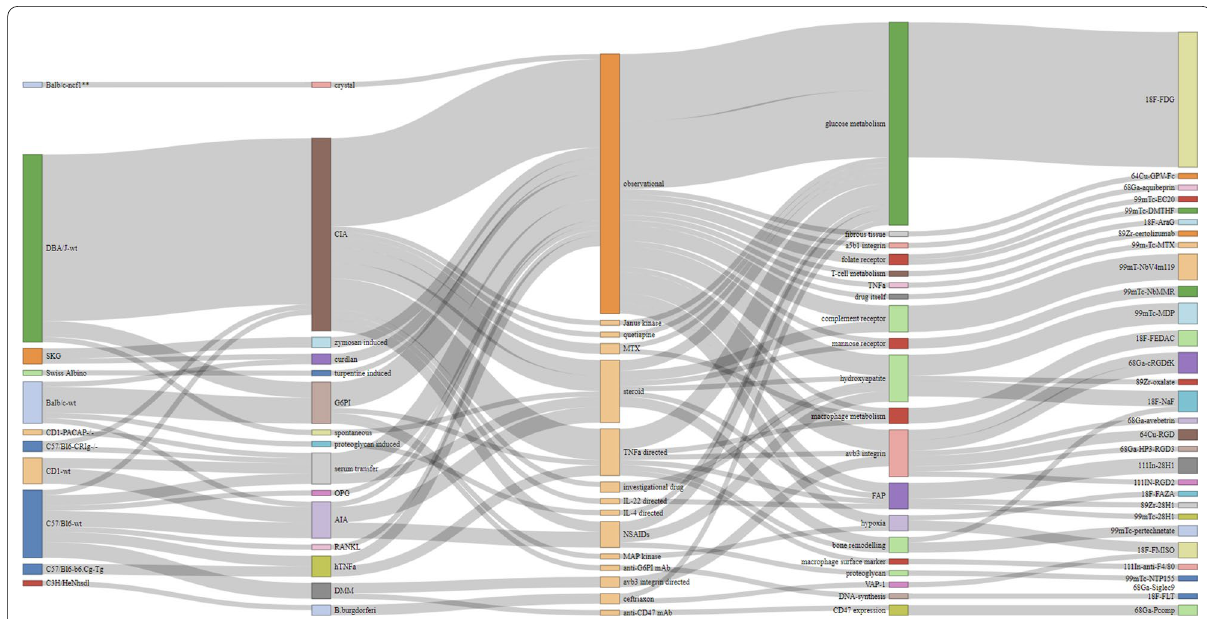
Fig. 1 Sankey diagram illustrating the landscape of imaging studies performed in mouse models of inflammatory musculoskeletal diseases by summarizing the interconnections between used mouse models, inflammatory triggers, study designs, imaging targets and tracers. Each line corresponds to one experimental study arm. Apart from dominant models DBA/J‑wt and C57/Bl6‑wt and collagen‑induced arthritis (CIA) as trigger in observational studies, there is a large heterogeneity in terms of triggers, interventions, imaging targets and tracers, resulting in a manifold of single studies with unique combinations. Interactive version of this figure is available at ??? (to be hosted on journal website)